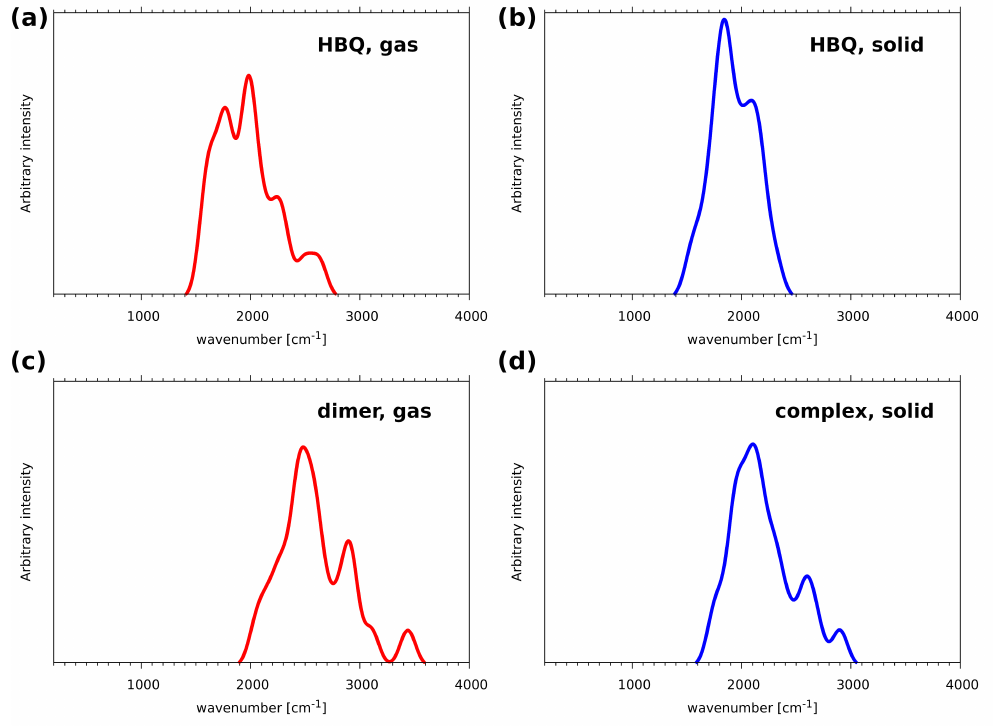
Figure 5. The O-H stretching mode envelopes calculated by a posteriori quantum corrections to the proton motion in the investigated O-H...N hydrogen bridges ( a ): HBQ in the gas phase, ( b ): HBQ in the crystal, ( c ): the benzo[h]quinoline-2-methylresorcinol complex in the gas phase, ( d ): the complex in the